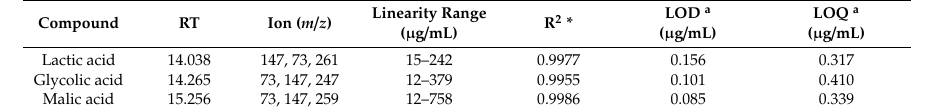
Table 1. Linearity and sensitivity data for organic acids (lactic, glycolic, malic acids) used as a standard. Compound RT